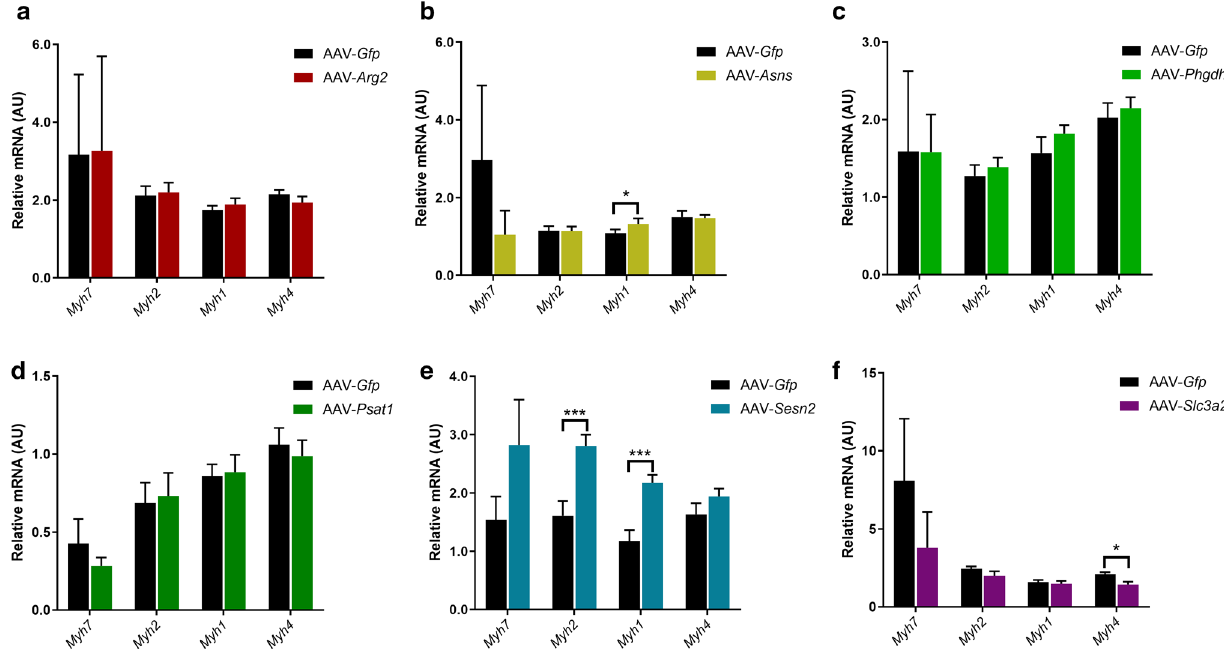
Figure 5. Effect of AAV-mediated overexpression of genes associated with an integrated stress response (ISR) on endogenous mRNA expression of myosin heavy chain (MyHC) isoforms. Relative mRNA expression for MyHC isoforms were determined in the Extensor Digitorum Longus (EDL) muscle following 28 days AAV- mediated overexpression of ( a ) Arg2 , ( b ) Asns , ( c ) Phgdh , ( d ) Psat1 , ( e ) Sesn2 and ( f ) Slc3a2 . Myh7 encodes MyHC-I, Myh2 encodes MyHC-IIA, Myh1 encodes MyHC-IIX and Myh4 encodes MyHC-IIB. All mRNA expression data were normalised to OliGreen, as a measure of total cDNA. Data presented as Means (n = 8, except AAV- Sesn2 n = 10) ± SEM. *( P < 0.05) and ***( P < 0.001) indicate significantly different to contralateral control limb injected with AAV- Gfp .